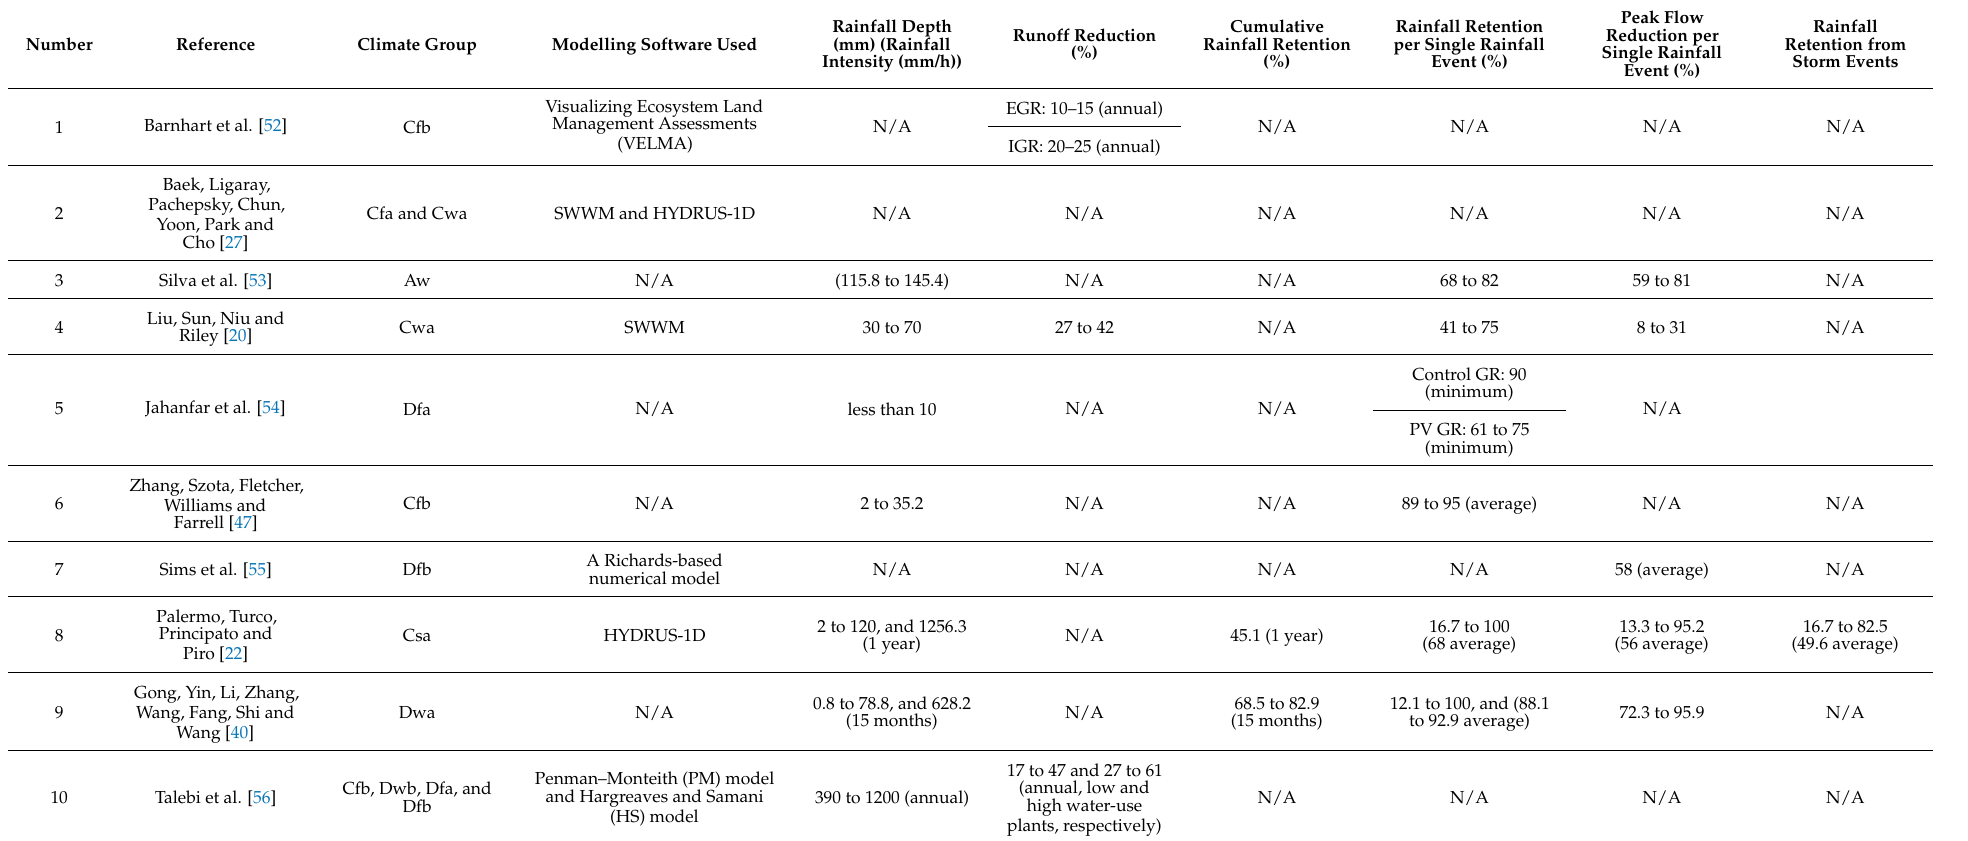
Table 1. Quantification of runoff reduction caused by green